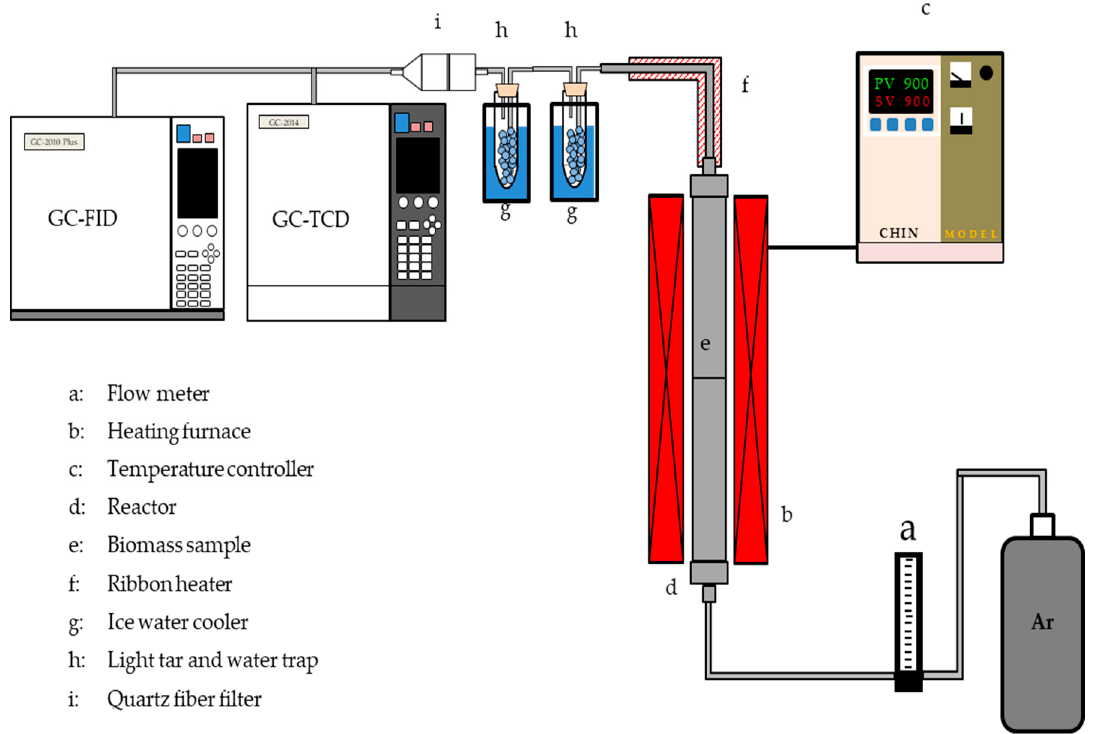
Figure 1. Experimental apparatus for pyrolysis and gasification product measurements.